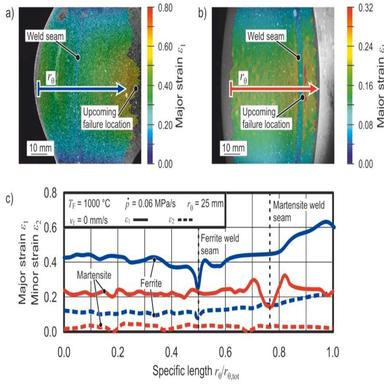
Strain distribution in the area of the weld seam near the failure of the specimen: a) DIC-image of the ferritic stainless steel, b) DIC-image of the martensitic stainless steel and c) distribution of major- and minor strain over the tangential radius.